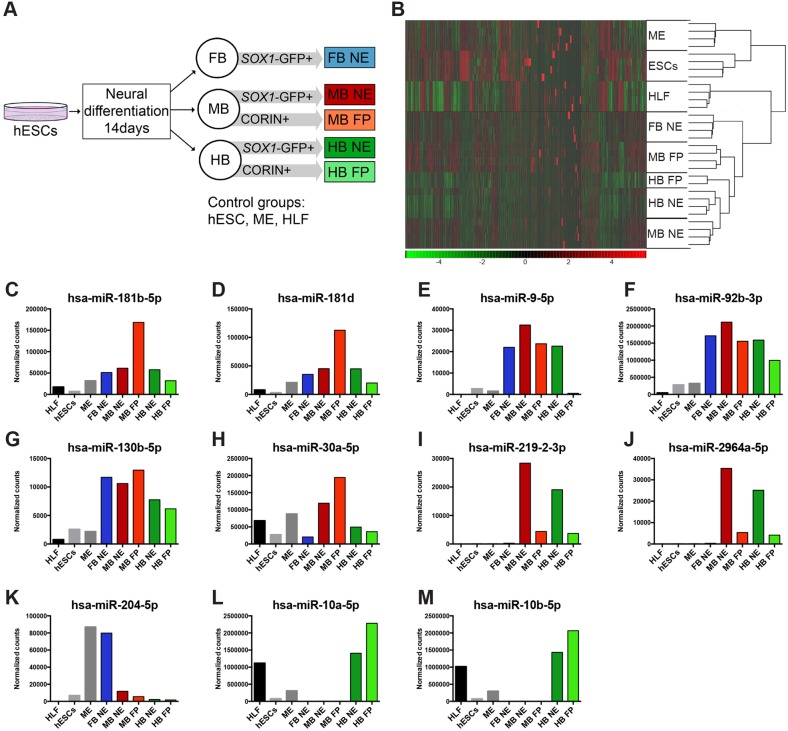
Expression of miRNAs in hESC-derived neural progenitors. (A) The different groups of cells were generated by differentiating SOX1-GFP hESCs towards FB, MB or HB for 14 days. At that point, cells were sorted for GFP+ or CORIN+, generating the NE and FP groups, respectively. (B) Heat map showing a random clustering analysis in which each neural subtype clustered together, revealing that cells possess a specific global miRNA expression pattern. (C-M) miRNAs with a fourfold or higher expression in NE cells compared with hESCs were extracted, and the normalized counts for selected miRNAs are shown.